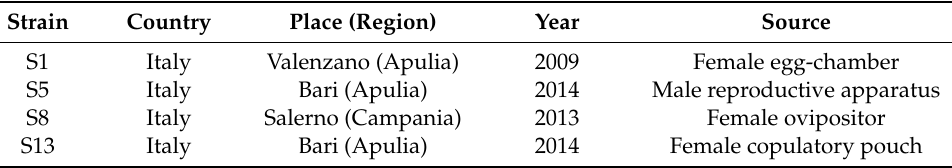
Table 1. Serratia marcescens strains analyzed in this